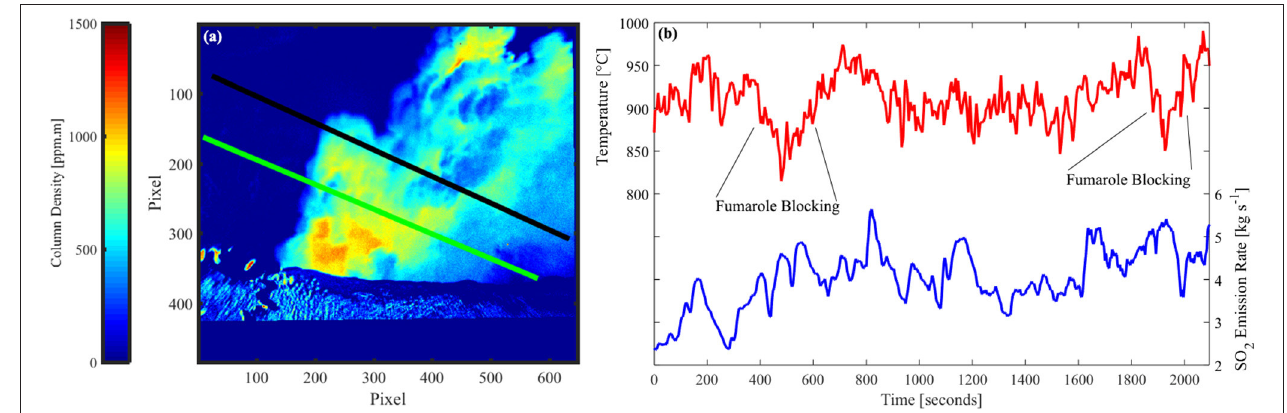
FIGURE 2 | (a) an example absorption image from 18th June with indicated integration lines for determining integrated column amount (green line) and plume speed via cross correlation (black line), (b) example temperature (red line) and SO 2 emission rate (blue line) traces through time during a period of synchronous acquisition on the 18th June.